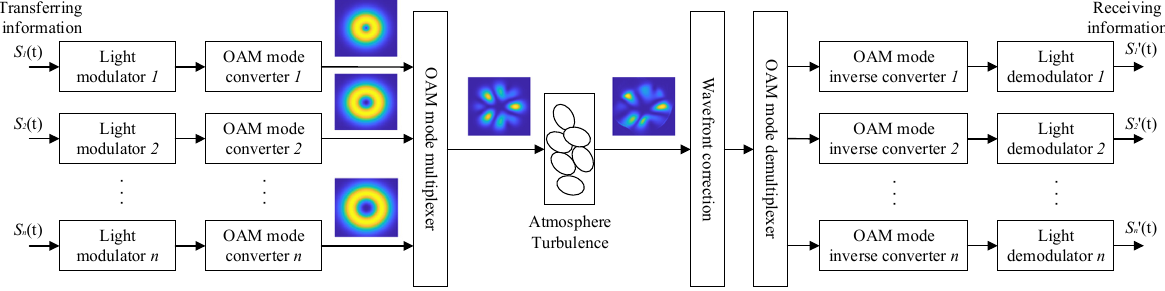
Figure 1. Block diagram of OAM state multiplexed communication system with wavefront correction. When the light wave passes through multiple phase screens, only the phase changes while the amplitude remains the same. Under the Rytov approximation, the expression for the optical field at a transmission distance of ∆ z can be obtained, as shown in the following equation